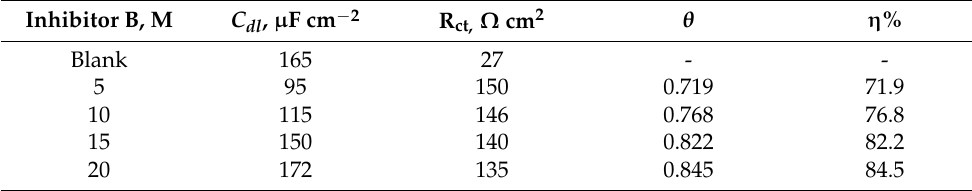
Table 8. Statistics from the EIS on the corrosion of Cu in 1.0 M HNO 3 in the absence and presence of numerous doses of